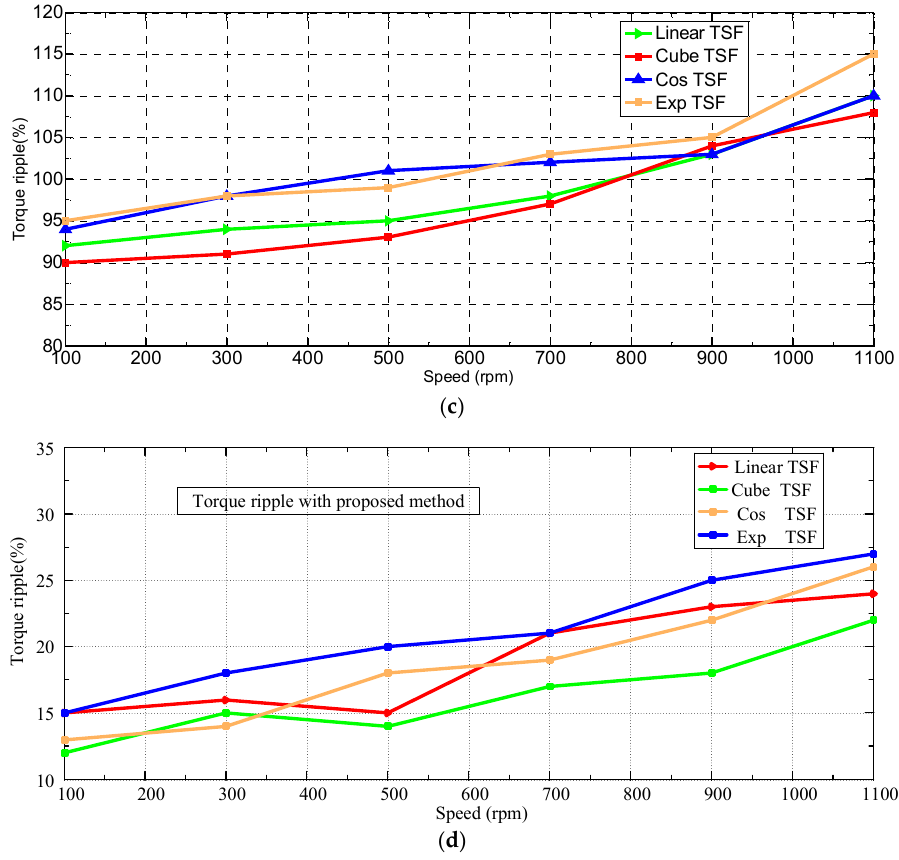
Figure 19. Current ripple and torque ripple with different method. ( a ) current ripple under CCC ( b ) torque ripple under CCC ( c ) current ripple under proposed method ( d ) torque ripple under proposed method.